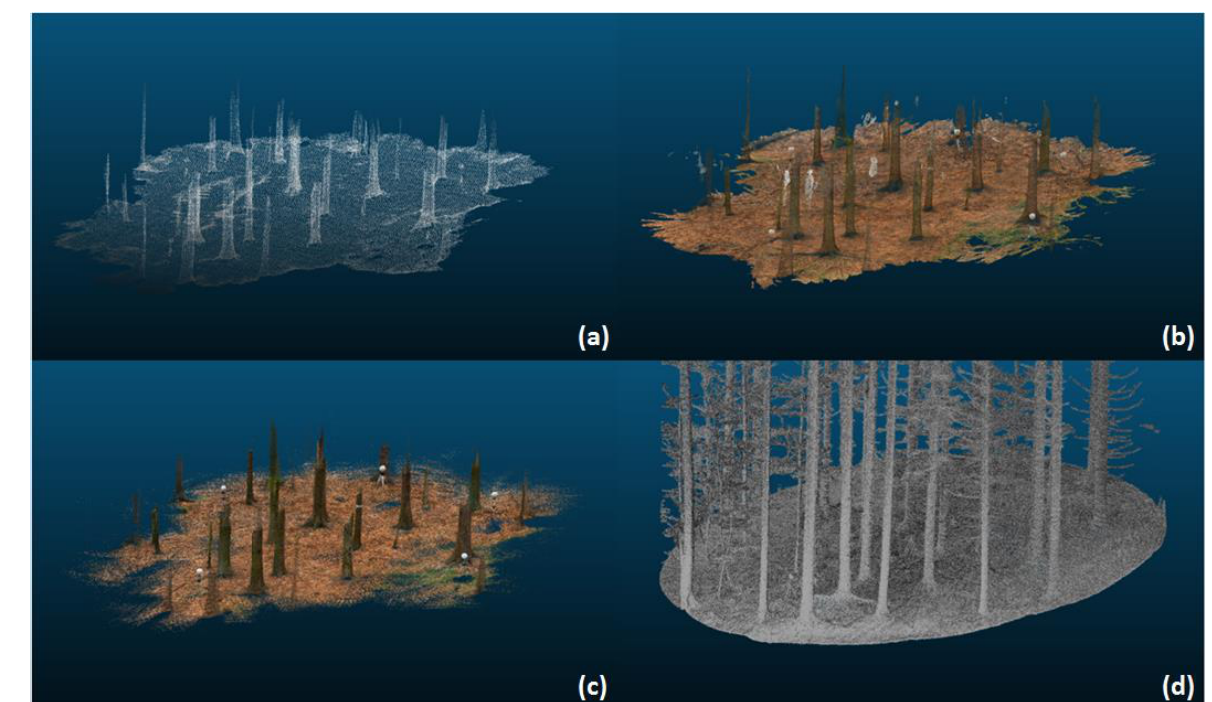
Figure 4. ( a ) Point cloud with 3D Scanner App. ( b ) Point cloud with Polycam. ( c ) Point cloud with SiteScape. ( d ) Point cloud with PLS.